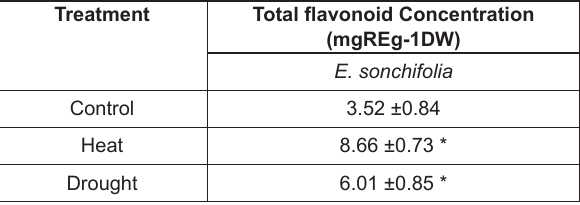
Data was represented as mean ± standard deviation of triplicate experiments. The treated samples with single asterisk (*) adhered indicate P < 0.05 and were statistically significant from control as determined by Dunnett’s test.